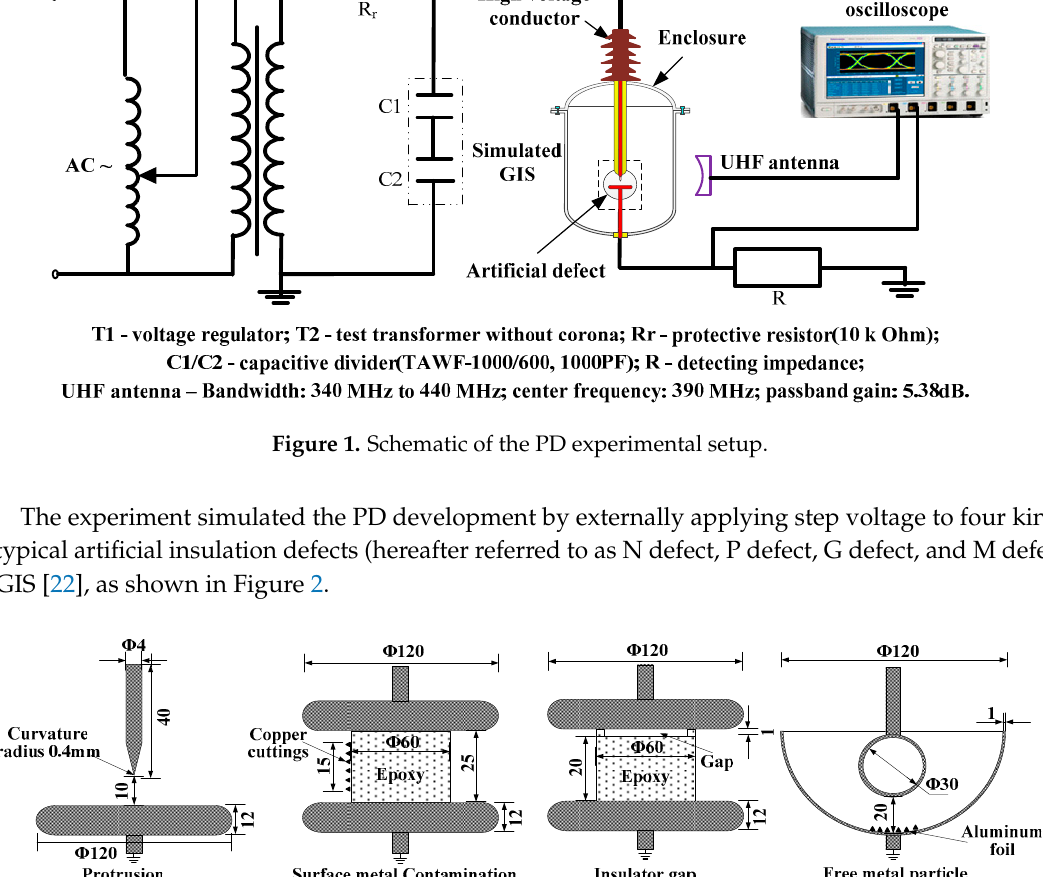
Figure 2. Four typical artificial defects in GIS (unit: mm).